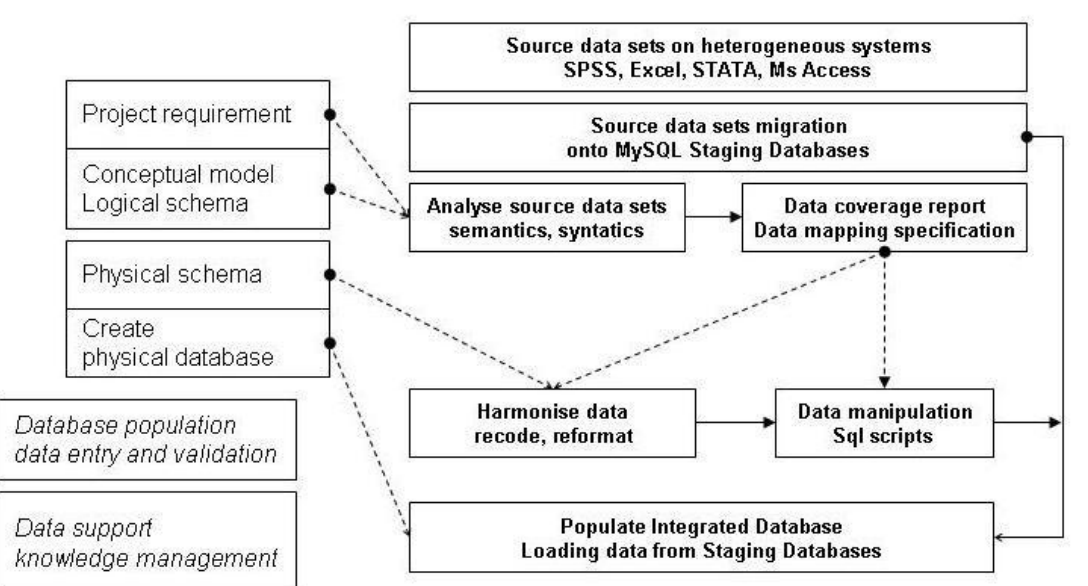
Figure 1: The left-hand side shows the process for top-down design path. The right-hand side shows our current approach, a reverse engineering path as we were committed to use existing data sets rather than populating the database using a pre-designed user interface with data validation procedures